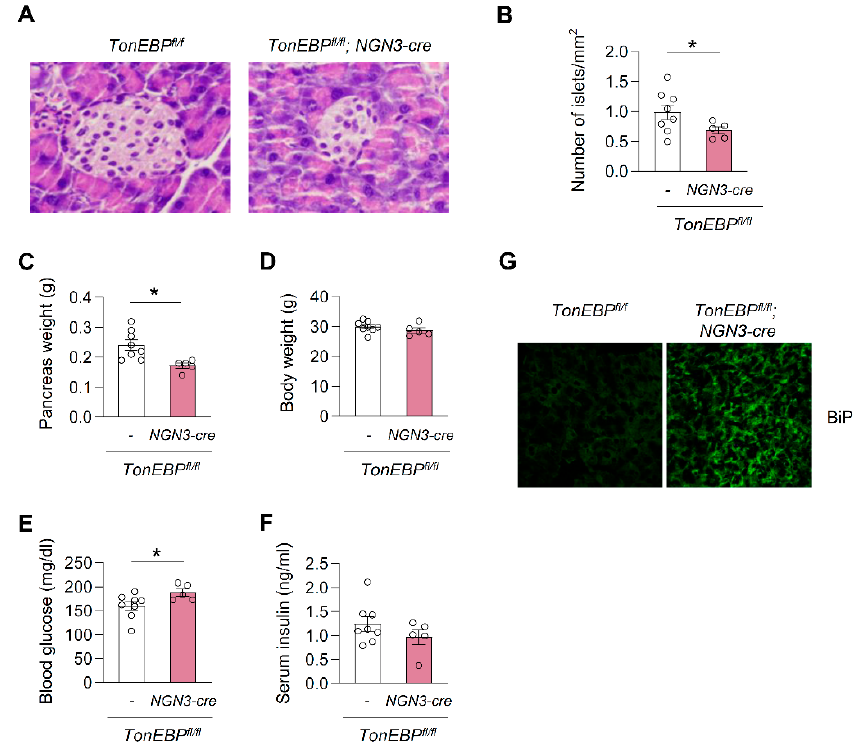
Figure 6. Smaller and fewer pancreatic islets in association with hyperglycemia in animals with islet-specific TonEBP deficiency. ( A ) Representative hematoxylin and eosin (H&E) stained images of pancreatic islets in TonEBP fl / fl ; NGN3 cre +/ − mice and their TonEBP fl / fl littermates. ( B ) Number of pancreatic islets per mm 2 of tissues sections are shown in ( A ). Pancreas weight ( C ), body weight ( D ), plasma glucose ( E ) and plasma insulin ( F ) were analyzed from 14 week old animals: TonEBP fl / fl ; NGN3 cre +/ − mice (blue, n = 5) and their TonEBP fl / f littermates (red, n = 8). ( G ) Representative fluorescence microscopic images showing BiP from TonEBP fl / fl ; NGN3 cre +/ − mice and their TonEBP fl / f littermates. n represents the number of biologically independent animals. Mean + SE, * p < 0.05 (( B – F ); unpaired t -